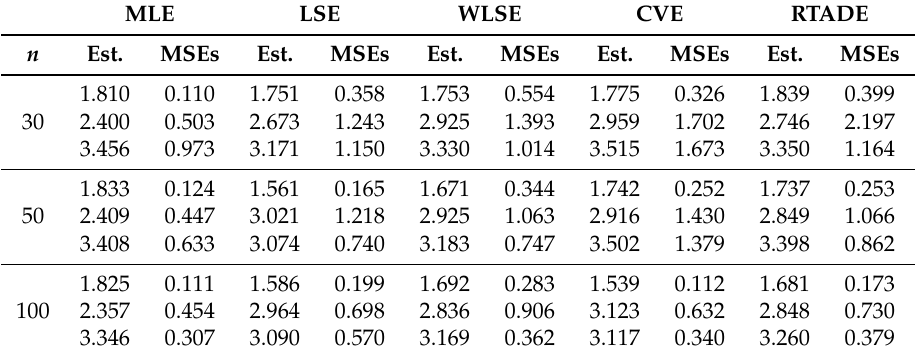
Table 5. Estimates and MSEs of TIHLIK model for ML, LS, WLS, CV, and RTAD estimates for the